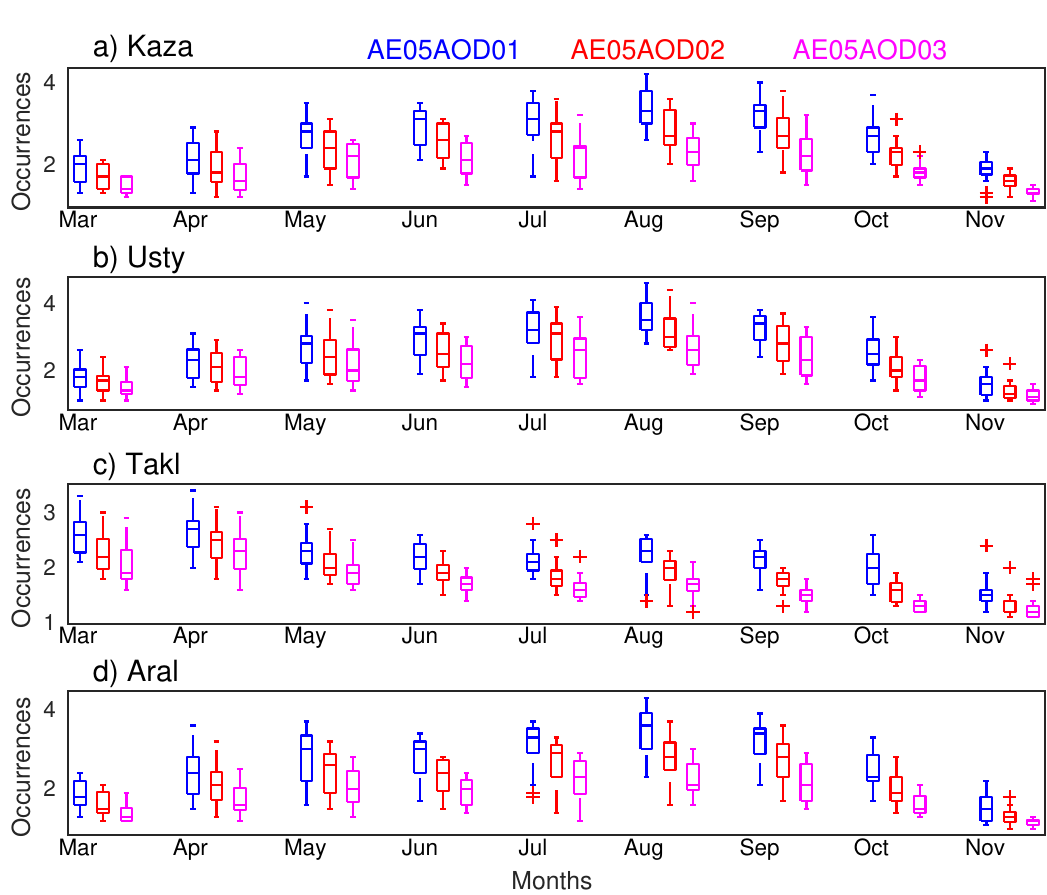
Figure 11. The statistic metrics of the annual distribution of dust occurrences that derived from MODIS/Terra AOD over the four sub-regions (( a ) Kaza, eastern Turkmenistan; ( b ) Usty, Ustyurt Pleateau; ( c ) Takl, the Taklimakan Desert; and ( d ) Aral, the Aral Sea Basin), as labeled in Figure 1, using three DODt (blue: 0.1; red: 0.2, and purple: 0.3). The red “+” indicates AOD/DOD of extreme